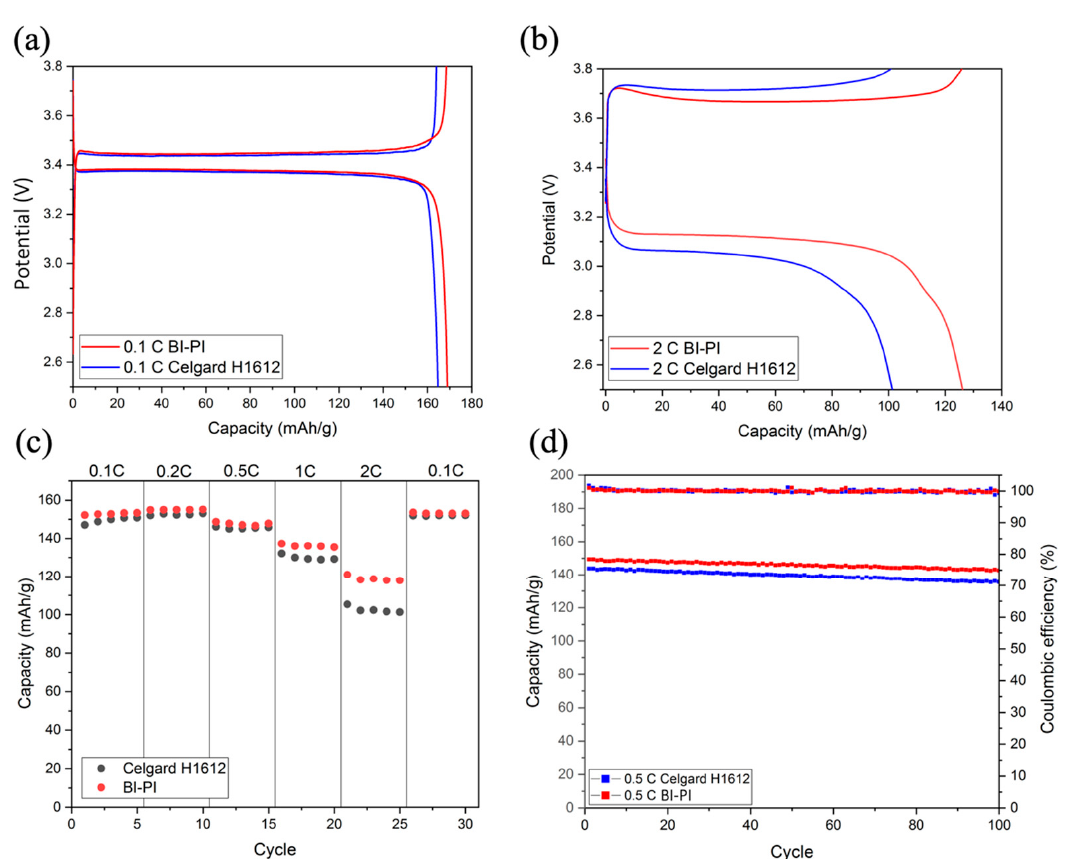
Figure 8. Charge-discharge curves of LiFePO 4 /Li half-cell system at ( a ) the first cycle at 0.1 C, ( b ) the 21st cycle at 2.0 C, ( c ) capacity at di ff erent current densities, ( d ) cycle stability test at 0.5 C.